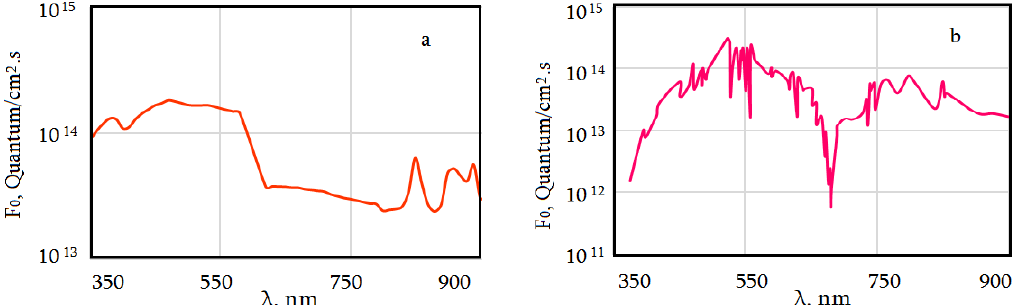
Figure 7. The measured ( a ), and experimental ( b ), spectral distribution of the intensity.